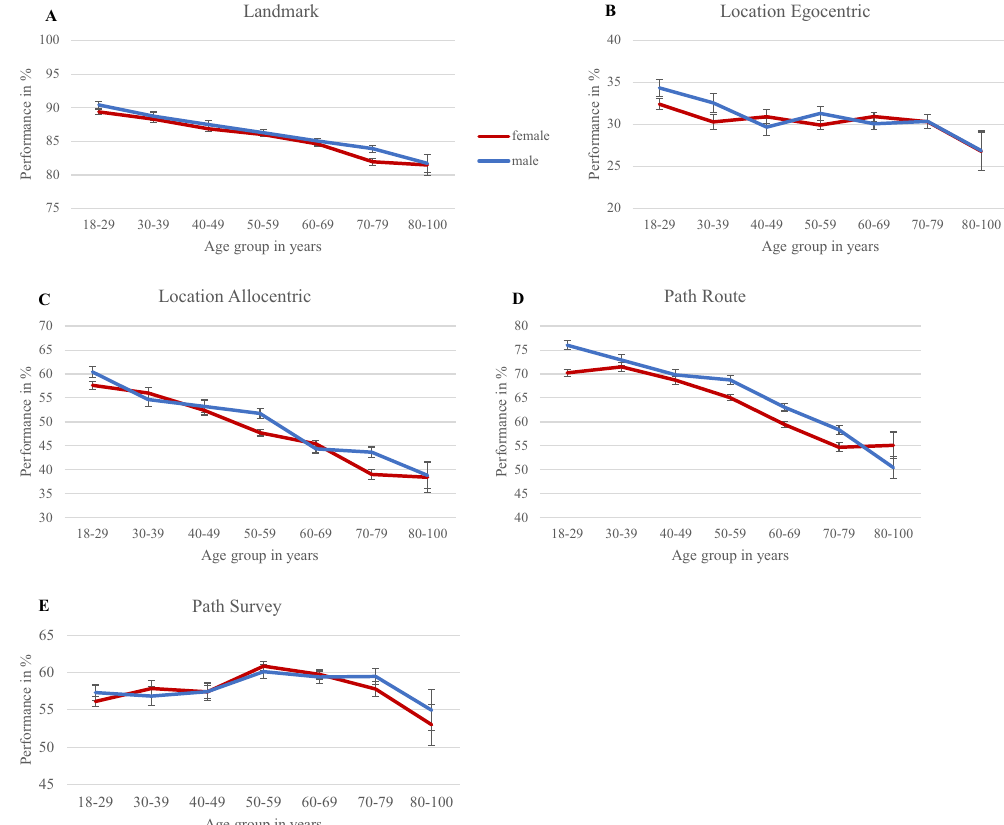
Figure 3. Estimated means of the performance of all adults, for each age group and gender on ( A ) Landmark task, ( B ) Location – Egocentric task, ( C ) Location – Allocentric task, ( D ) Path – Route task, ( E ) Path – Survey task. Error bars represent standard error of the